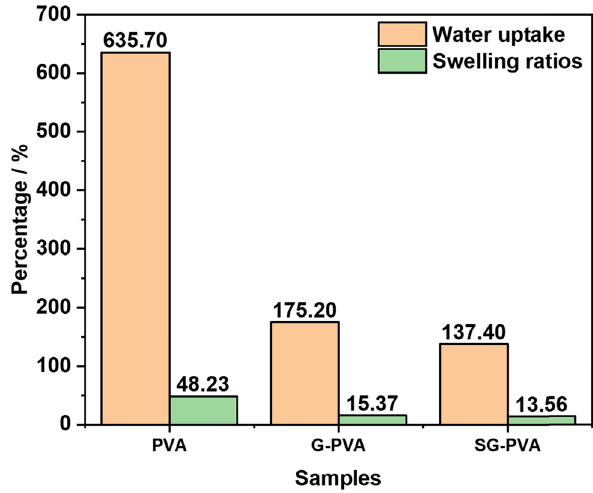
Figure 3: Water uptake capacity of PVA, G - PVA, and SG - PVA.